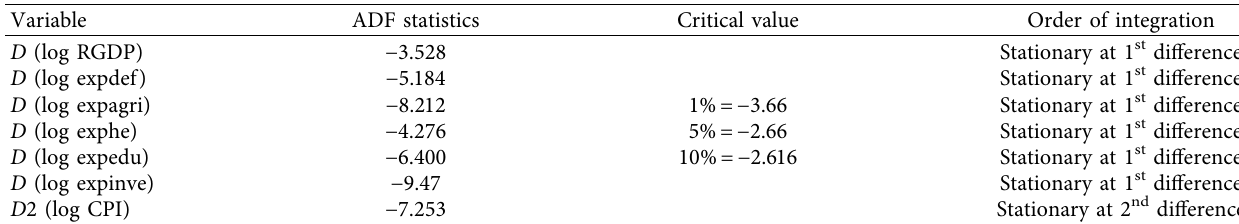
Figure 7: Trend of consumer price index and RGDP. Source: own computation based on the data from MOFED and National Bank, 2022. Table 4: Augmented-dickey fuller test results at frst